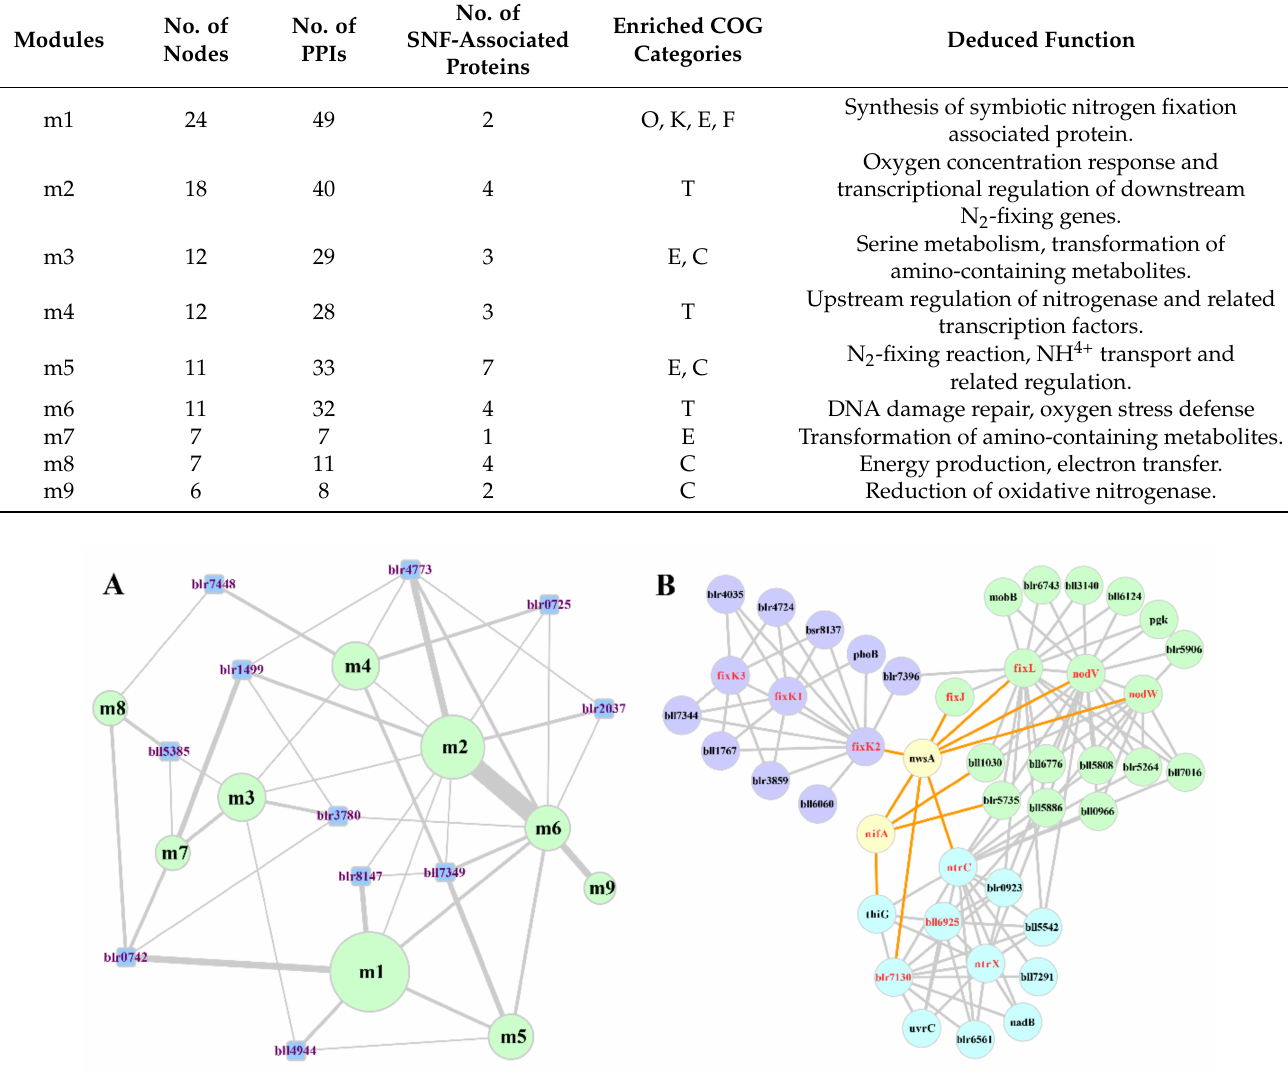
Figure 7. Subnetworks related to key modules (MCL clusters) and TOMs in the SNF core-sub-network. ( A ) Sub-network related to nine key modules (light-green nodes) and 11 TOMs (light-blue nodes). The diameter of a key module node corresponds to the number of proteins in this module. The width of an edge between two nodes corresponds to the number of PPIs. ( B ) Subnetwork related to NwsA (including its interacting modules and TOMs). Light-green, blue and purple nodes represent the m2, m4 and m6 modules, respectively. Nodes with red labels represent the SNF-associated